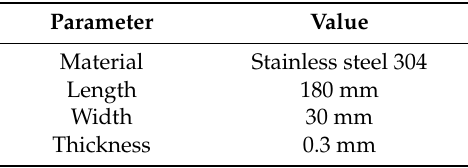
Table 2. Parameters of the small cantilever